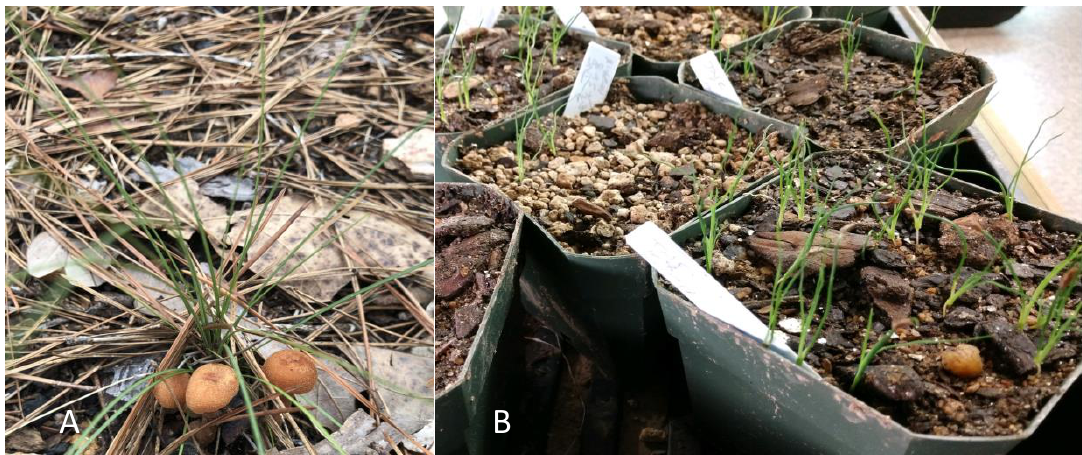
Figure 9. ( A ) Xerophyllum asphodeloides plants after one year in the field. ( B ) Whole seed germinated after prolonged stratification.